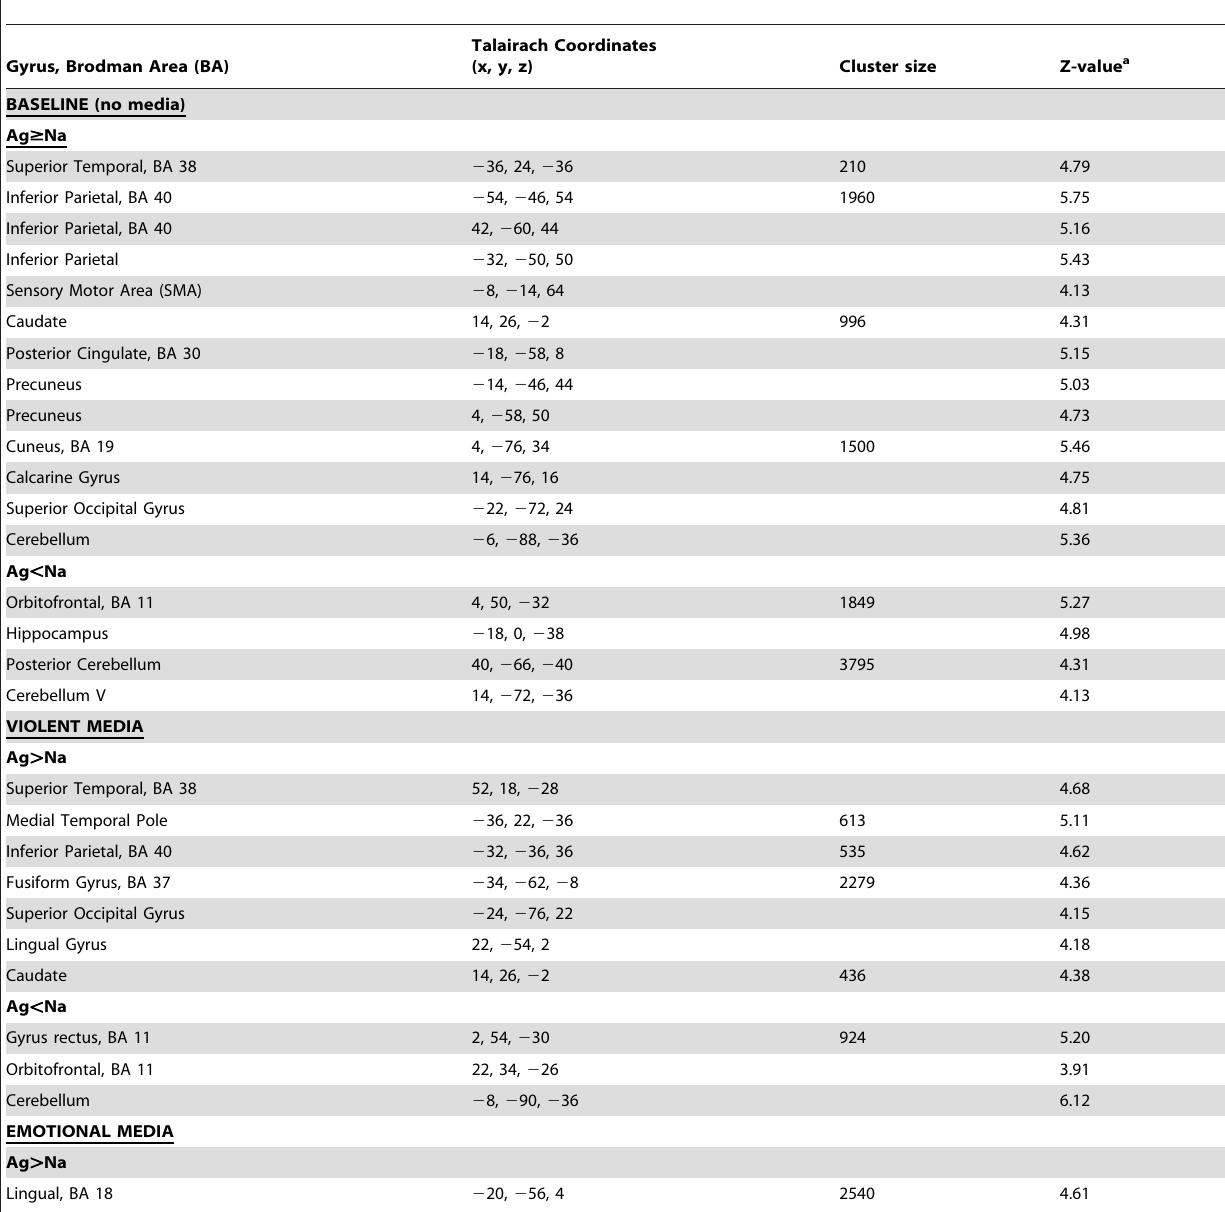
Table 2. Statistical Parametric Mapping results showing the clusters where normalized brain metabolism was significantly different as a function of